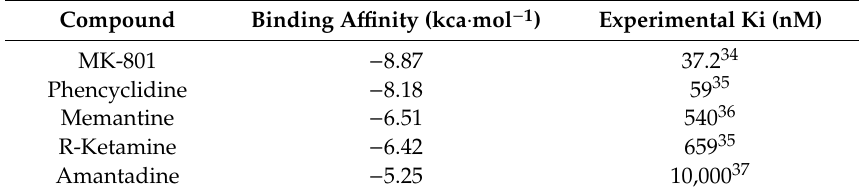
Table 2. Binding a ffi nities and experimental inhibition constants (Ki) values of the known NMDA receptor